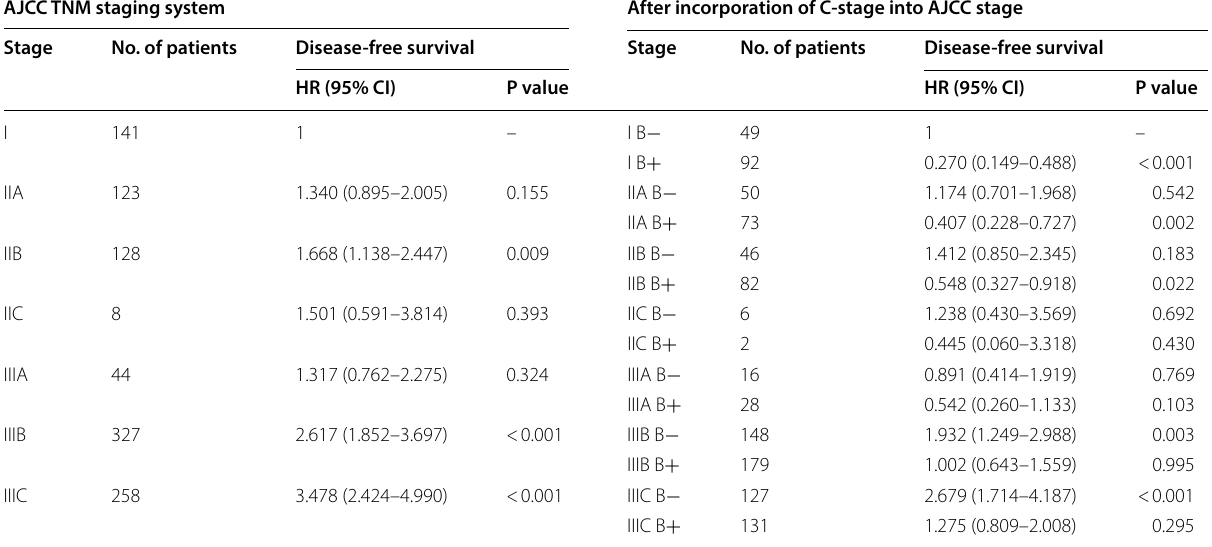
system AJCC TNM staging system